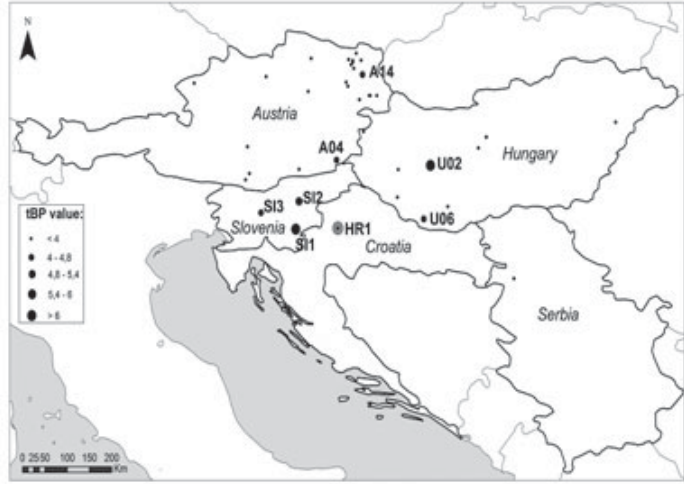
Figure 5 Teleconnection of Kobiljak near Zagreb oak chronology (HR1) with local oak chronologies from Austria, Hungary, ≥ 4 are indicated with progressively large points and labels, small points Slovenia and Serbia; the chronologies showing t BP without label represent chronologies with t < 4; for details of teleconnection see Table 2 BP